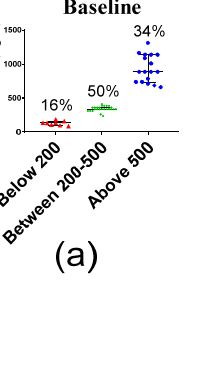
Figure 4. Serum IL6 levels before and after vitamin D supplementation. ( a ) Baseline levels, ( b ) day 1 levels, and ( c ) day 30 levels. ( d ) Columns represent the median serum IL6 concentration at baseline, day 1 and day 30, and error bars indicate interquartile range. Data were analyzed by non-parametric repeated measure ANOVA followed by Wilcoxon signed-rank multiple comparison test. *** p < 0.001.